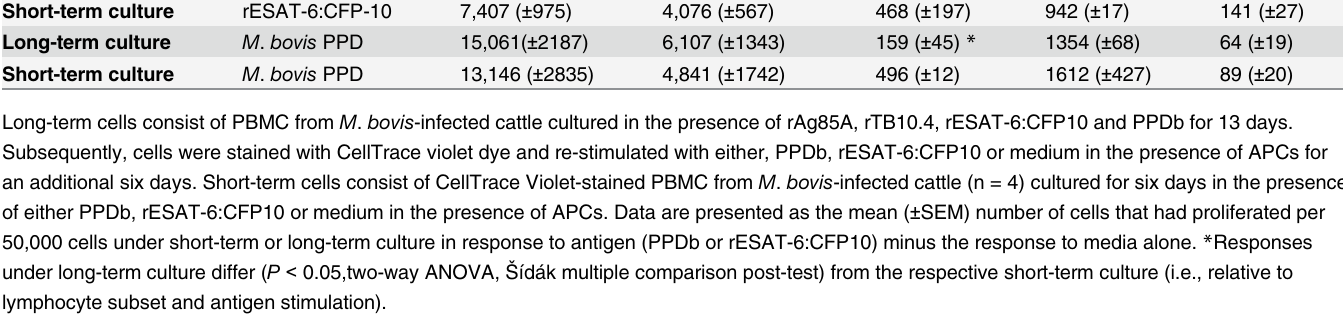
14-day cultured cells re-stimulated with antigen for an additional 6 days) was further assessed. Again, PBMCs cultured under short-term culture conditions (6 days only) were used for com- parison (Fig 6). The distribution of CD4 T cells into Tcm and effector subsets was different be- tween short- and long-term conditions following stimulation with rESAT-6:CFP10 (Fig 6C) or PPDb (Fig 6D). Greater ( P < 0 . 05 ) numbers of Tcm cells were present in long-term (13 + 6 days) versus short-term (6 days) cultures; while more effector cells were present ( P < 0 . 05 ) in short — versus long-term cultures. The numbers of Tem and naïve cells were similar between the two conditions. Tem cells were the main population in both cultures, whereas few naïve cells persisted under either culture condition (Fig 6C and 6D). These findings indicate that highly proliferative Tcm cells partially revert to effector (predominately Tem) phenotypes upon additional exposure to antigen for 6 days (Fig 6C and 6D as compared to Fig 3).